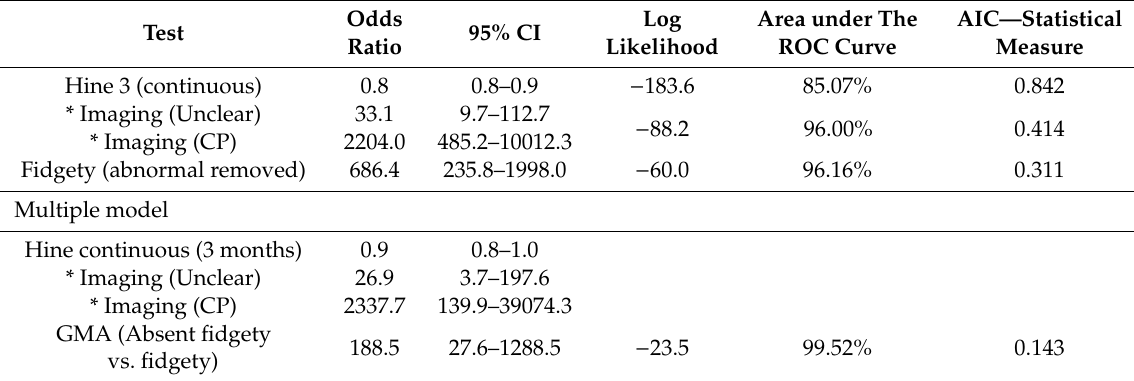
Table 3. Logistic regression of all